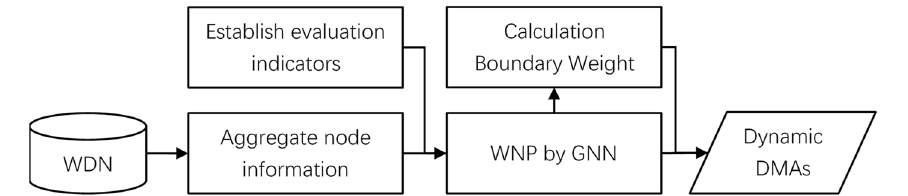
Figure 2. Flowchart of the process for integrated WNP and dynamic